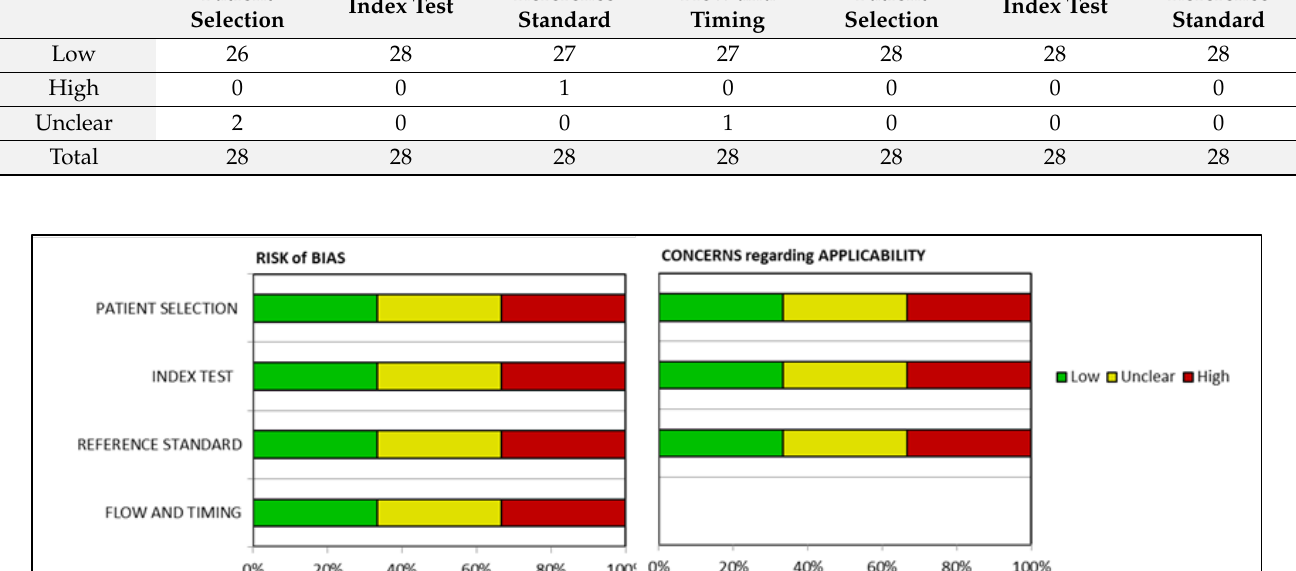
Figure 2. Bias risk results assessed through QUADAS-2.